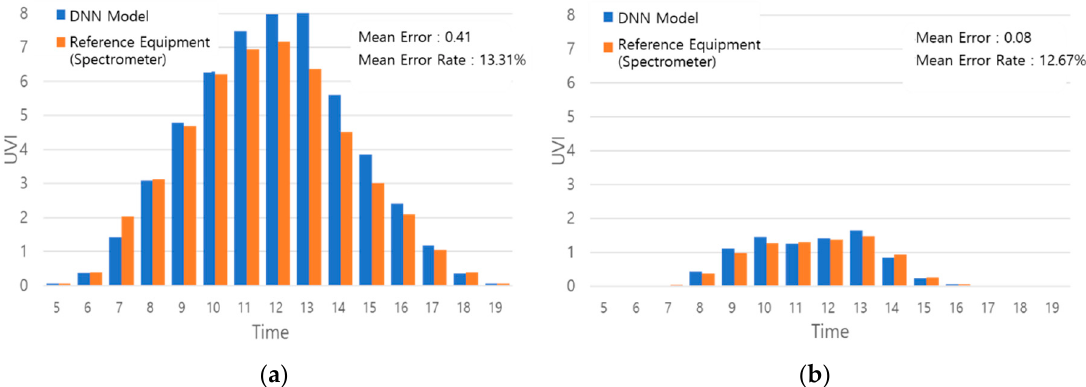
Figure 7. Experiment for UVI calculation performance of the mobile DNN model. ( a ) Summer(12 June 2019); ( b ) Winter(27 November 2019).